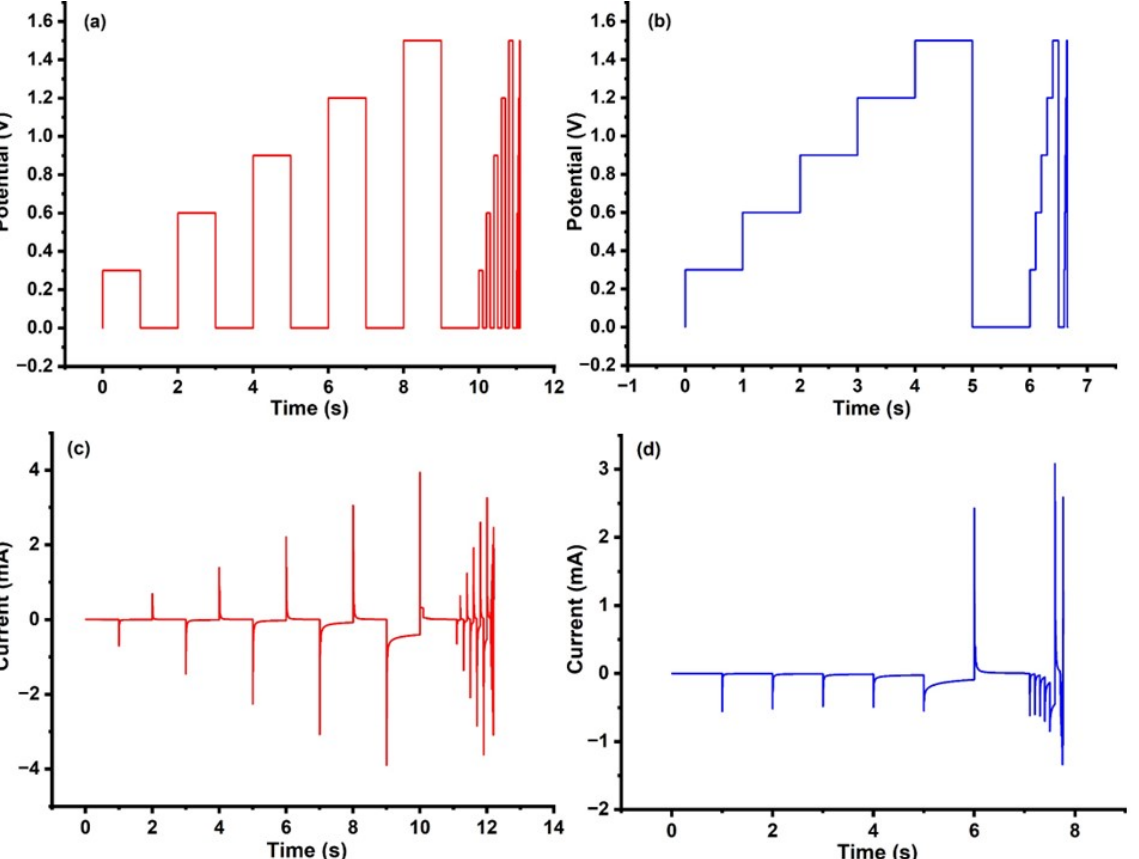
Figure 6. Trigger signal of Squares wave ( a ) and trapezoidal wave ( b ); response curve of S1 on Glu electrode triggered by squares wave ( c ) and trapezoidal wave ( d ).